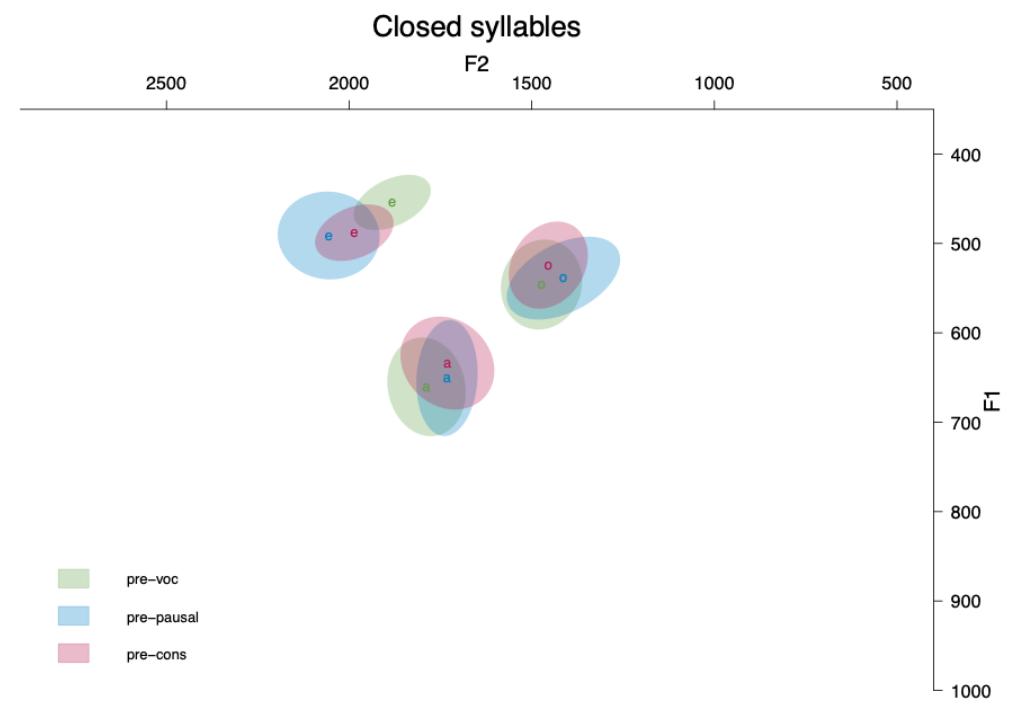
Figure 5. Vowel plots for realisations of /e, o, a/ in unstressed, closed syllables in pre-vocalic (green), pre-pausal (blue) and pre-consonantal (red)